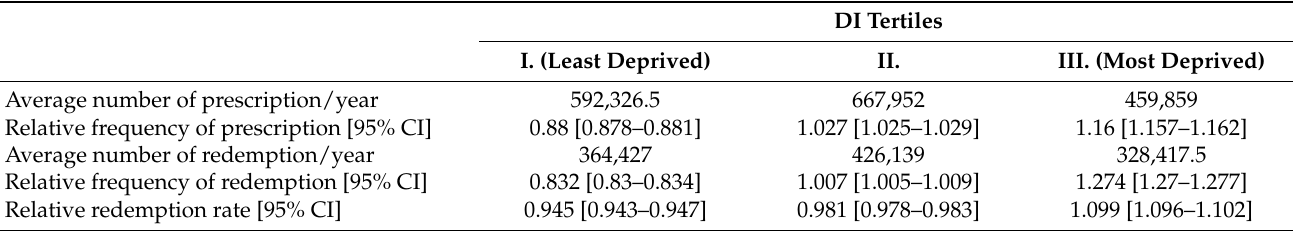
Table 2. Relative frequency of prescription, redemption, and the relative redemption rate of metformin per 100 persons aged 20+ years at district level by deprivation tertiles, compared to the national average, in Hungary, 2018–2019.